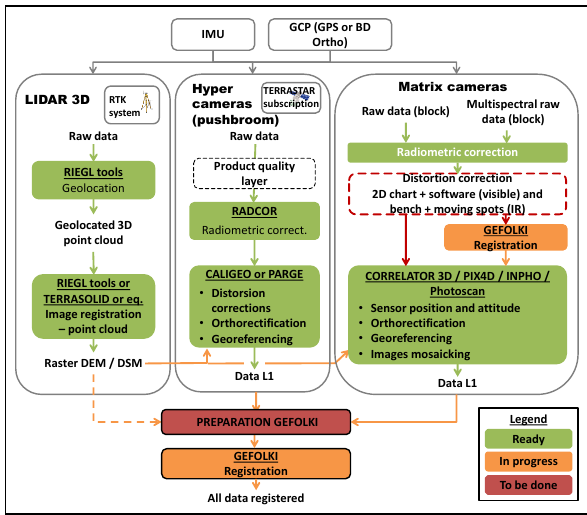
Figure 10. TERRISCOPE processing chain